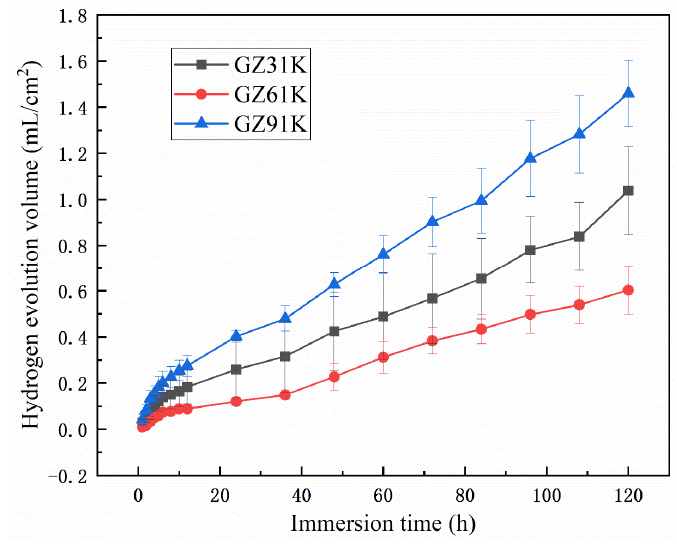
Figure 6. Hydrogen evolution curves of the T6-treated alloys immersed in SBF for 120 h. Table 5. Corrosion rates (mm/year) of the T6-treated alloys calculated by different methods.